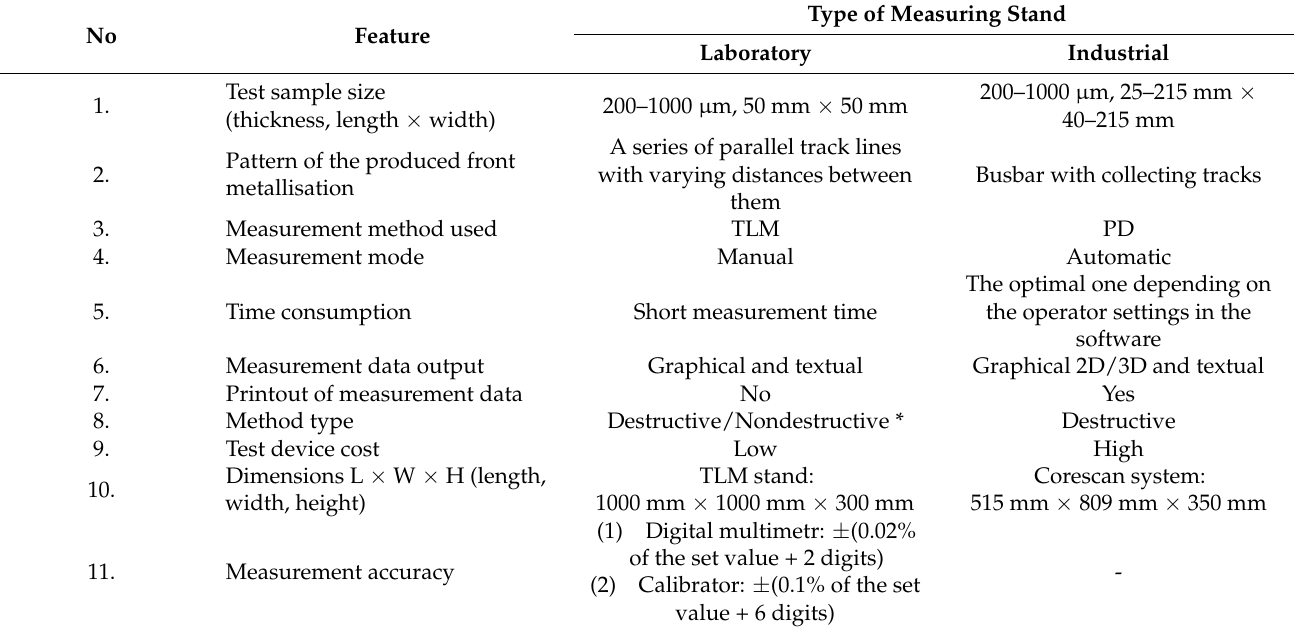
Table 2. Primary specifications of the available research equipment